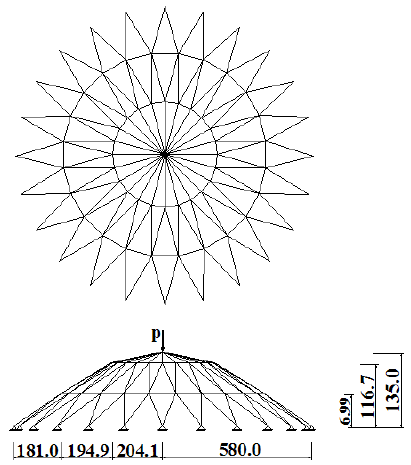
Figure 8. Space truss with 168 – members, all dimensions are in mm [28] .